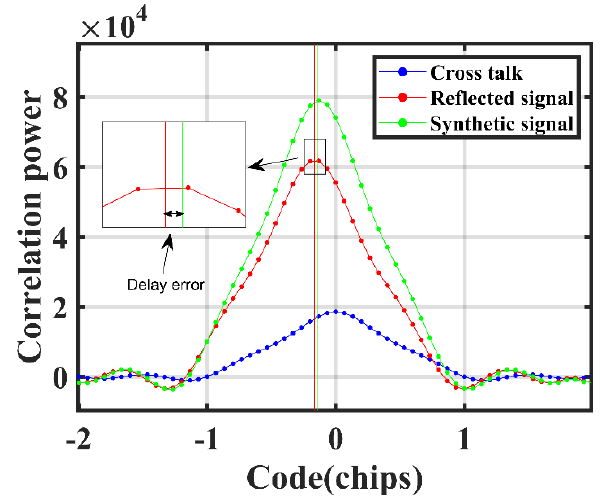
Figure 3. The delay map of the crosstalk signal, the reflected signal, and the synthetic signal.